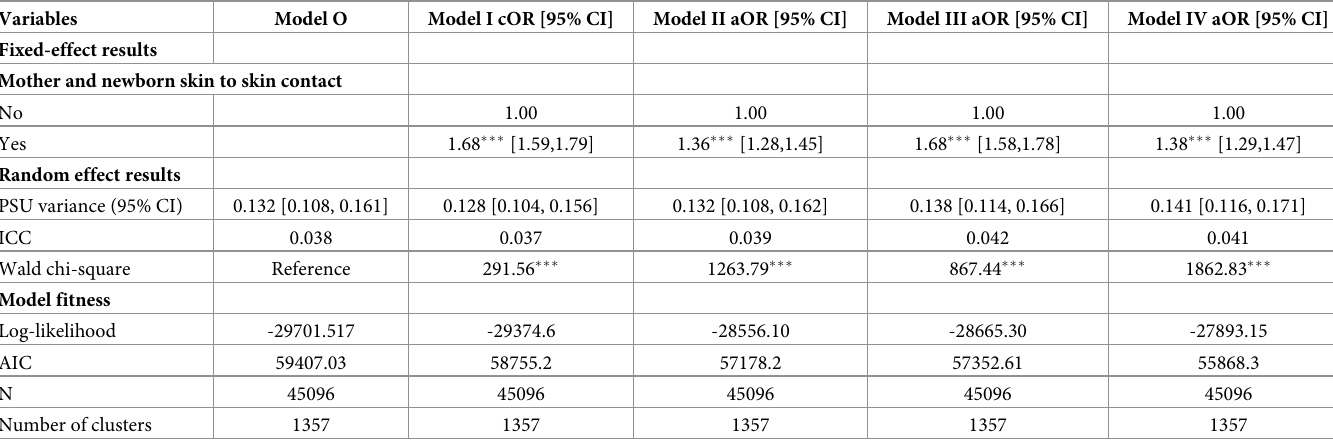
Table 3. Fixed and random effect analysis of association between mother and newborn skin to skin contact and timely initiation of